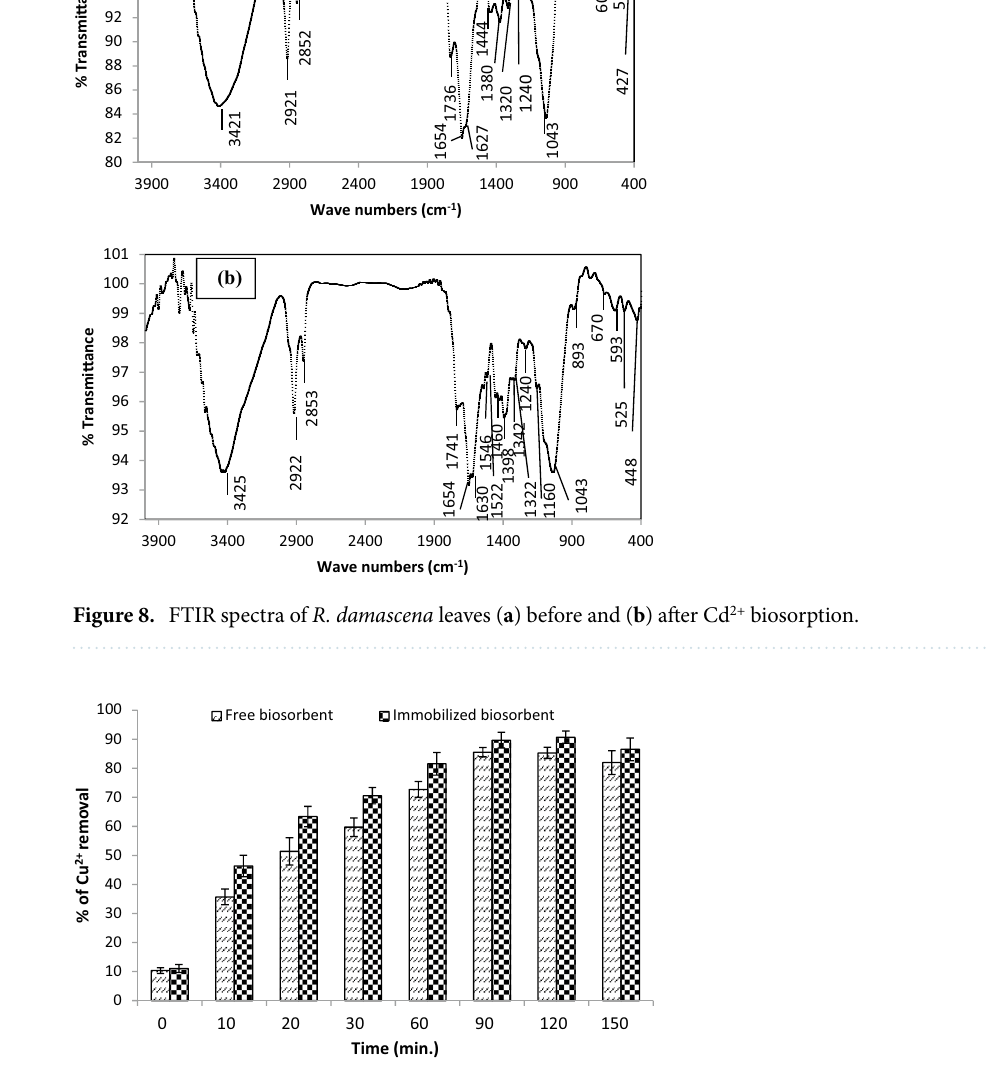
Figure 9. Copper ion removal by Ca–alginate-immobilized R. damascena